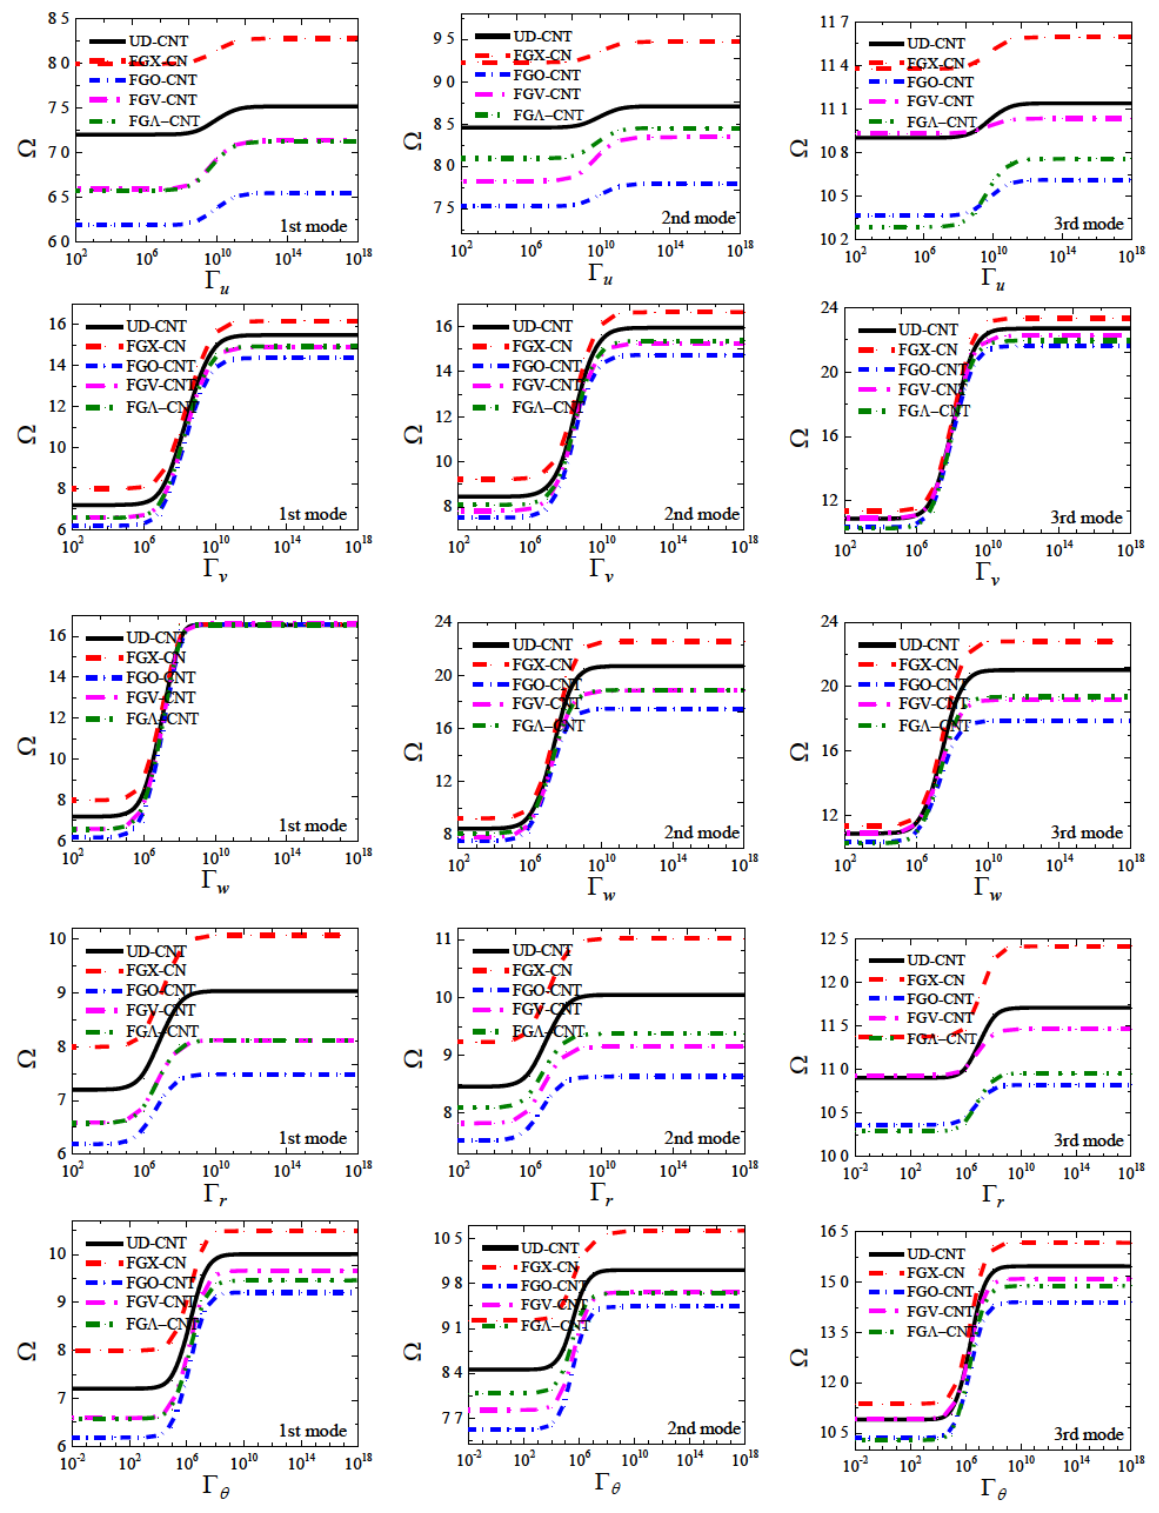
Figure 8: Variation of the first three frequency parameters Ω versus the elastic restraint parameters for FG-CNT reinforced composite panel with CCCC boundary condition ( V tcnt